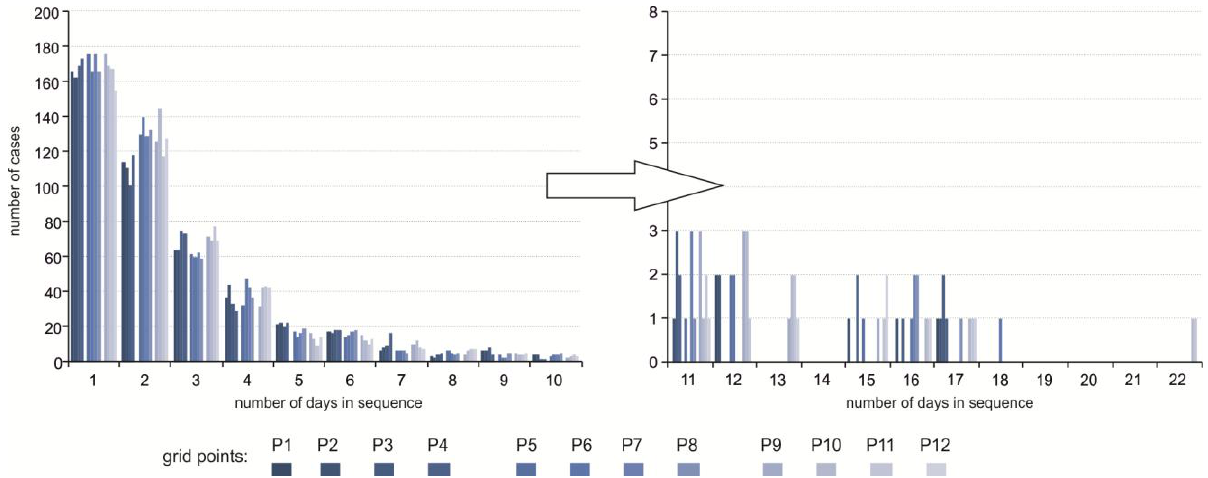
Fig. 6. Number and length of sequences of days with SHP occurred at particular grid points in the period 1951-2015